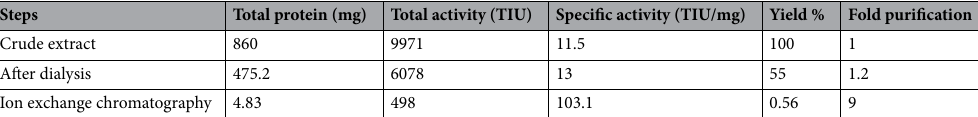
Table 1. Purification profile of SSTI. Total amount of protein extracted from 10 g of fine powder of dried seeds of S. surattense. TIU (trypsin inhibitory activity unit) was defined as the decrease in 0.01 unit of absorbance at 410 nm.